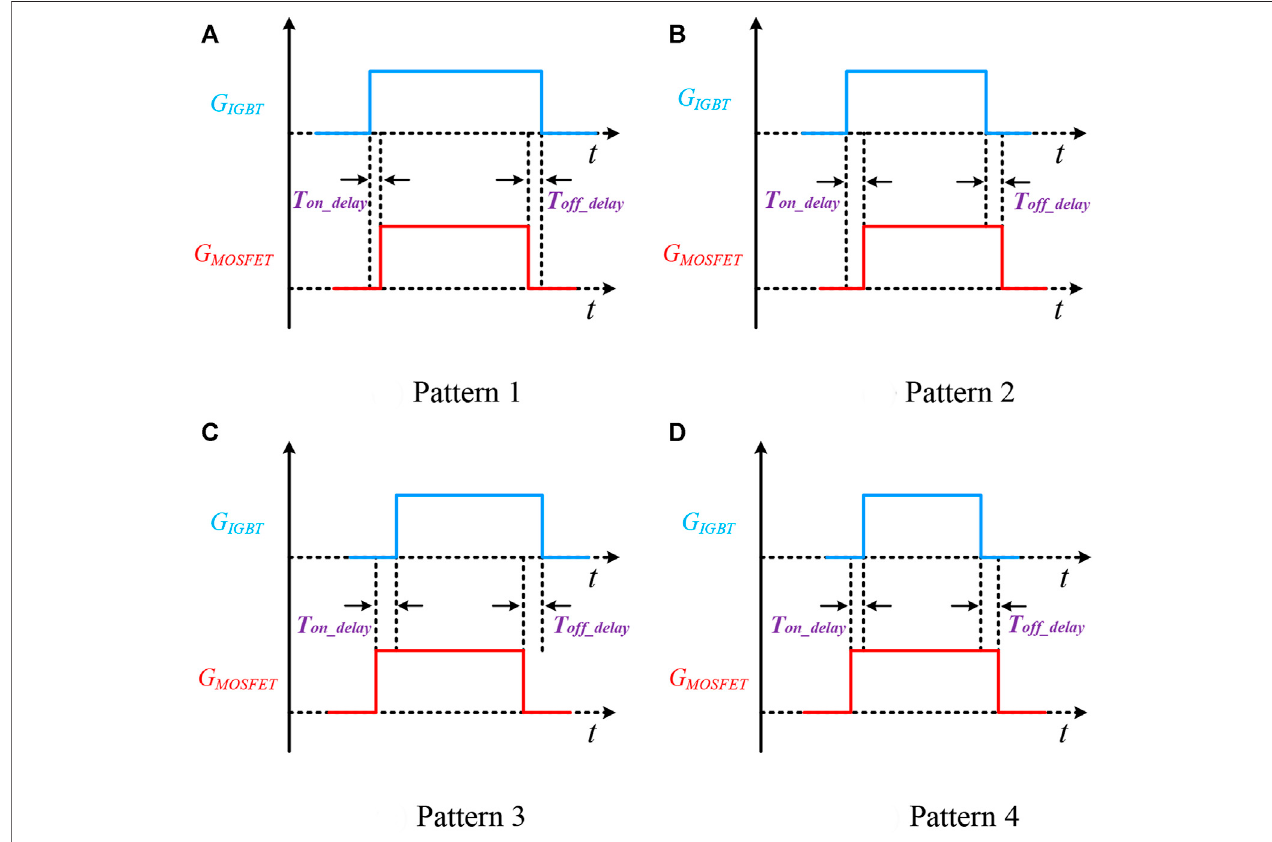
FIGURE 3 | Switching patterns of the Si/SiC hybrid switch. (A) Pattern 1, (B) pattern 2, (C) pattern 3, and (D) pattern